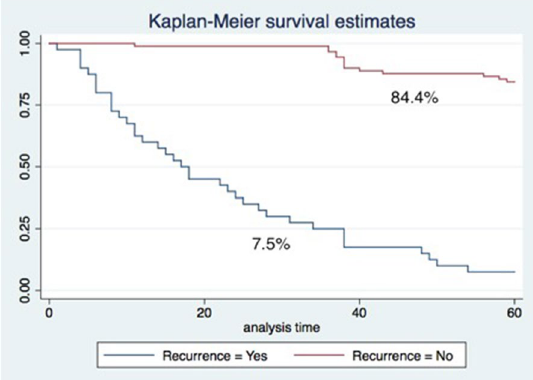
Fig. 3 Kaplan-Miere curve of overall survival (5 years) of oral tongue squamous cell carcinoma stratified on